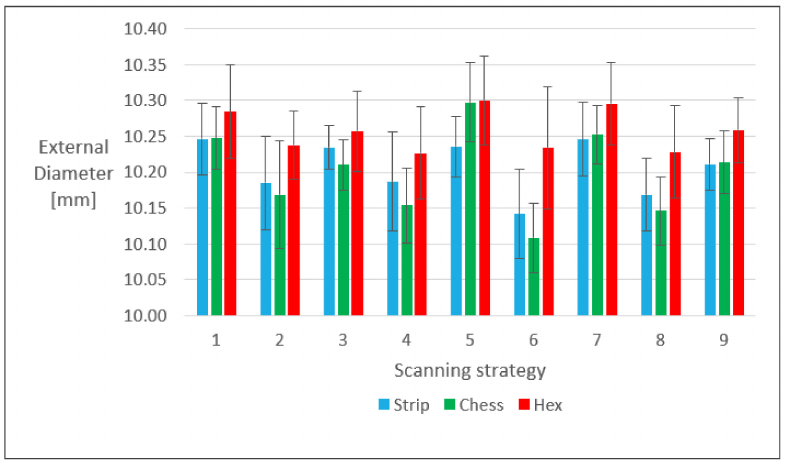
Figure 4. External diameter (average values and standard deviation) of the as-built specimens belonging to different sets of prints 1, 2 and 3.